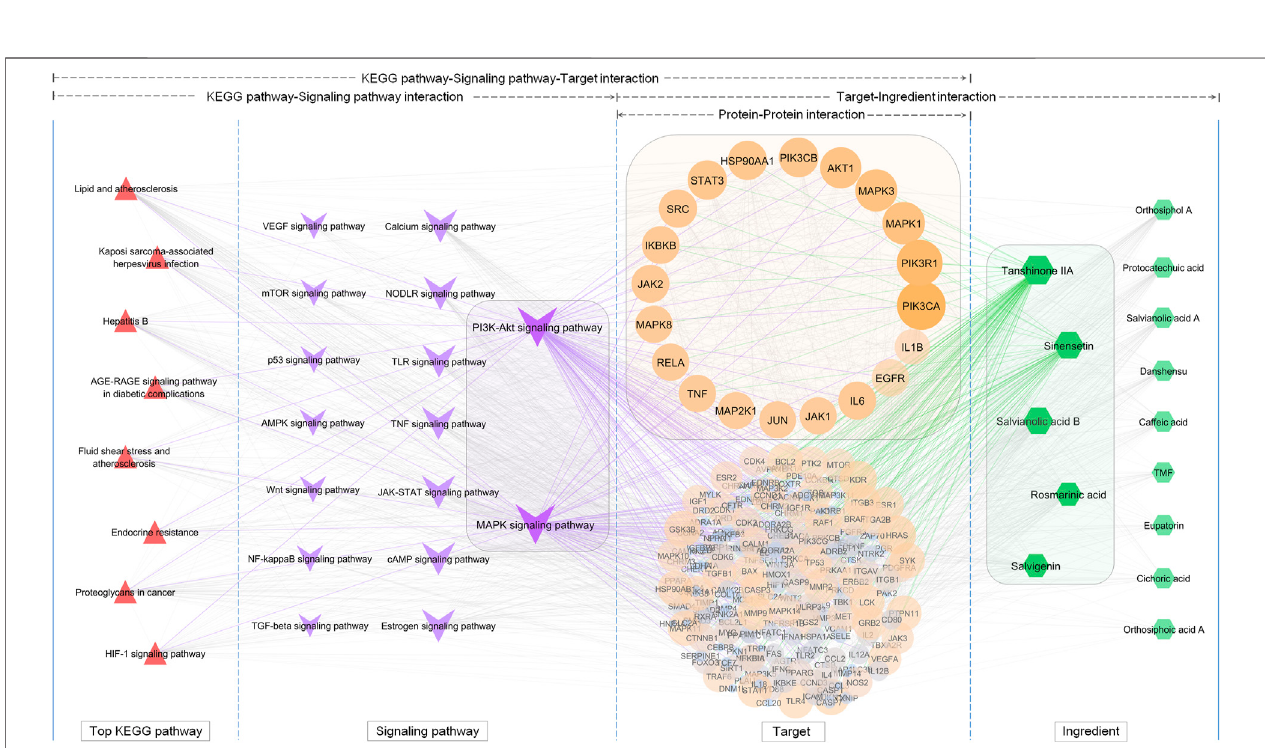
FIGURE 5 | The terms of 37 non-repetitive KEGG pathways retained from the pool of top KEGG pathways for each OSB-disease pair. Among them, eight KEGG pathways were shared by all OSB-disease pairs and a representative KEGG pathway was shown in which OSB-disease intersection targets were labeled with color. hsa05417: lipid and atherosclerosis; hsa05161: hepatitis B; hsa05205: proteoglycans in cancer; hsa05167: kaposi sarcoma-associated herpesvirus infection; hsa04066: HIF-1 signaling pathway, hsa05418: fl uid shear stress and atherosclerosis; hsa04933: AGE-RAGE signaling pathway in diabetic complications, hsa01522: endocrine resistance. OSB Orthosiphon stamineus Benth.